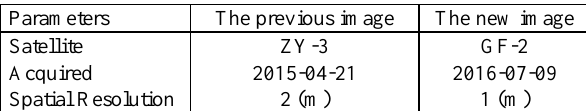
Figure 1. Technical route of classification accuracy inspection